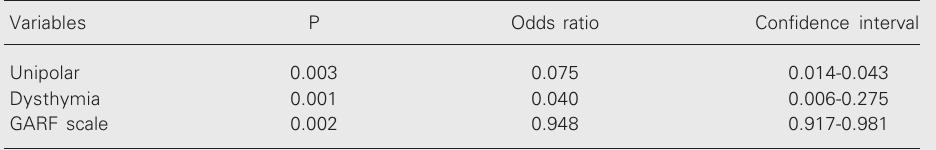
GARF = Global Assessment of Relational Functioning